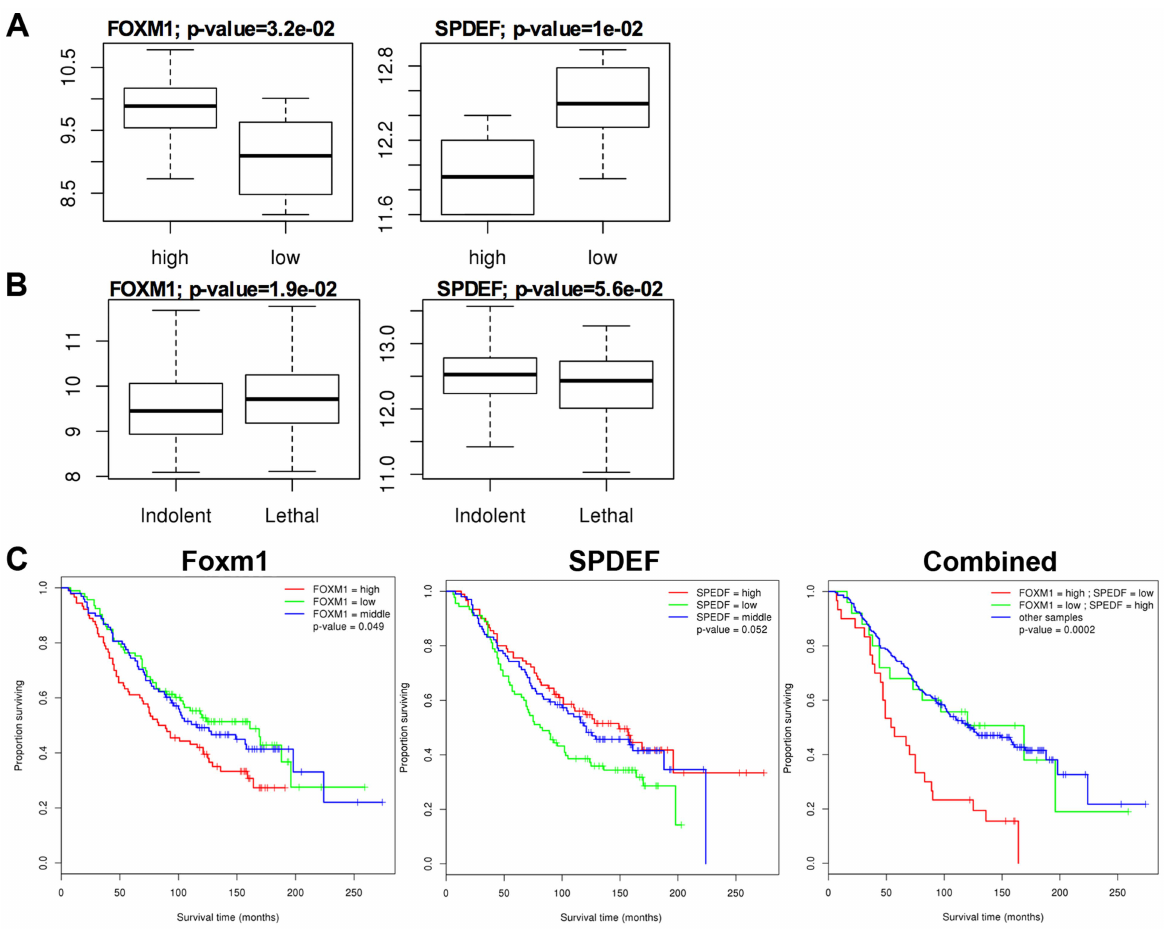
Figure 6. SPDEF expression is inversely correlated with Foxm1 expression in human prostate cancer and of prognostic value for the prostate carcinoma patient survival. The data from two human prostate cancer microarray datasets, GSE21034 [30] and GSE16560 [31] were downloaded from the GEO archive. Expression levels were compared between Indolent and Lethal prostate cancers ( A ), and High-risk and Low-risk sample groups ( B ). High-risk samples were derived from patients with surviving less than 12 months and low-risk samples from patients surviving more than 192 months. C . Two-gene expression signature predicts poor patient survival. Kaplan-Meier survival analysis of prostate cancer patients using dataset GSE16560 [31]. Patients were stratified by the expression level of FOXM1 or SPEDF, or both together. The group with ‘‘high’’ FOXM1 and ‘‘low’’ SPDEF expression had the worst outcome (median survival time of 55.5 months).